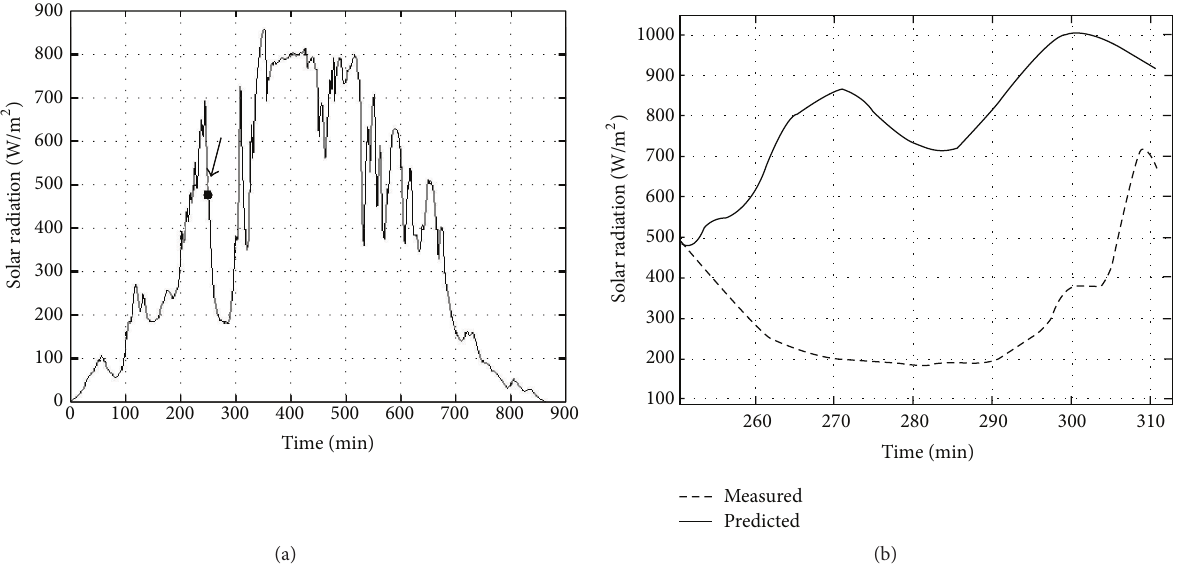
Figure 3: In (a), the solar radiation measured at the 8 of July of 2001. In (b), the sixty-step ahead prediction of the solar radiation, from the point identified in (a), using a 10th order AR